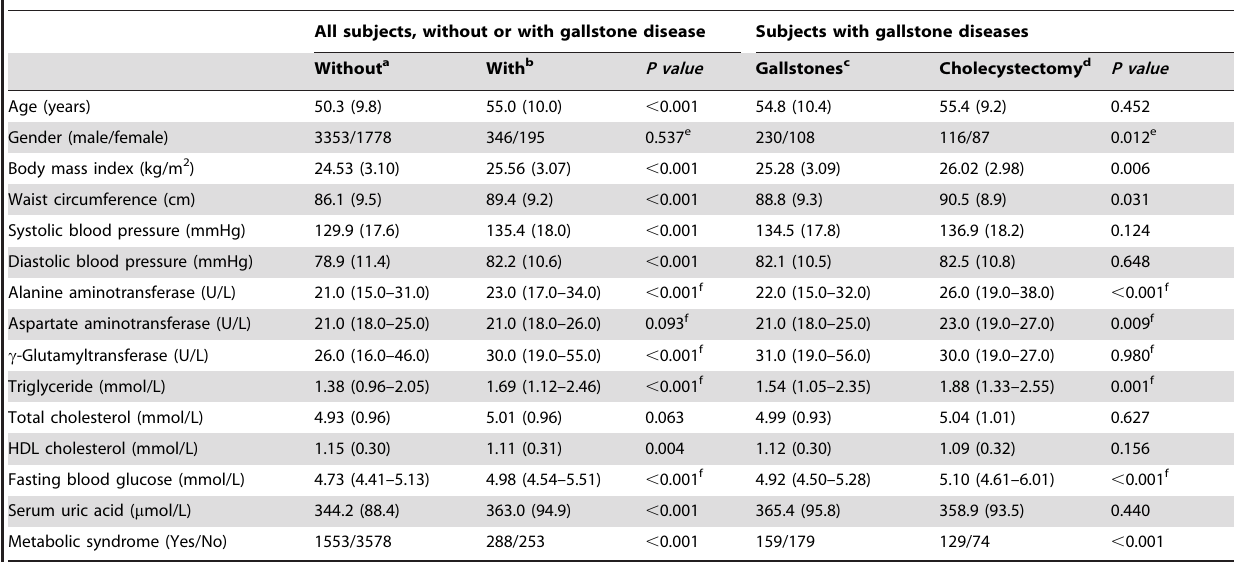
Table 1. Demographics and clinical characteristics of the subjects according to gallstone disease status.